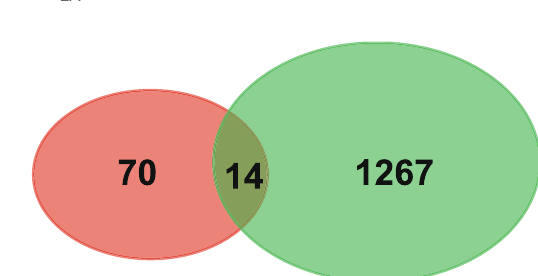
Nature Communications| (2023) 14:1880